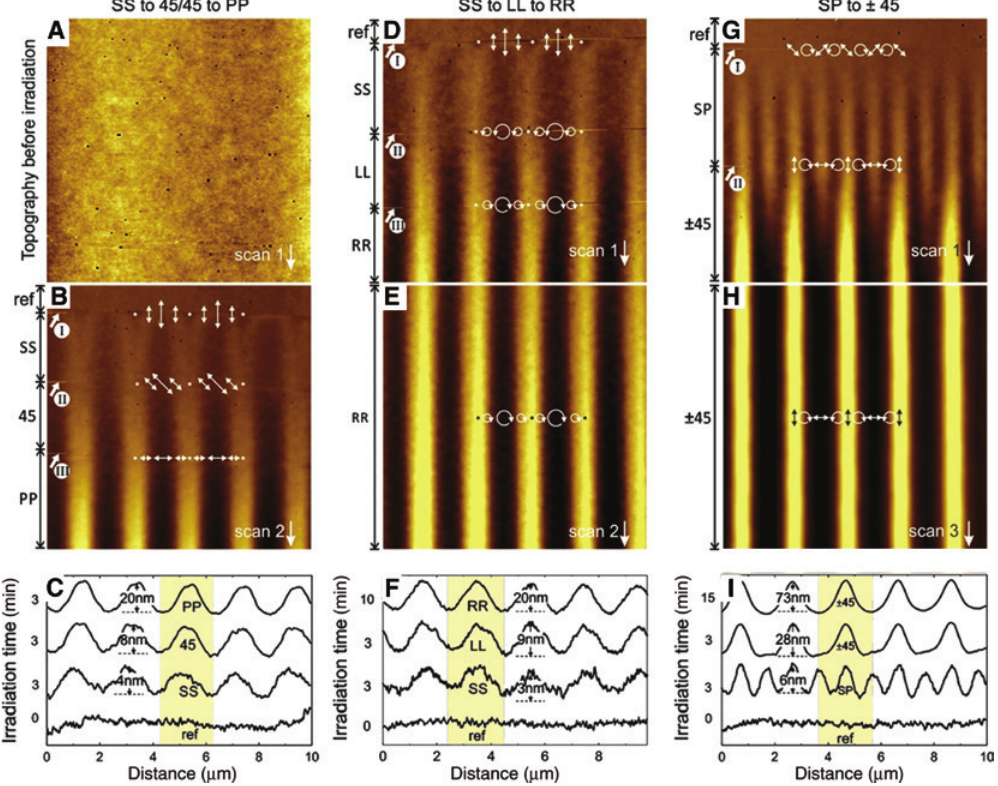
Figure 4: SRGs induced by different polarization combination and recorded by real-time in situ AFM. The vertical direction in the AFM images corresponds to a time axis. (A) Topography before the irradiation. (B) Time evolution of the film topography obtained by switching the polarization of the two interfering beams from S-S to 45 ° -45 ° to P-P at the positions indicated by the Roman numbers. (D–E) Same as before for polarization switches from S-S, to left circular (L-L) and to right-circular (R-R). (G–H) Same as before for the pure polarization interference patterns produced by S-P and + 45 ° / − 45 ° polarized beams. The topographic profiles relative to each polarization configuration are shown in panels (C, F, I). Reprinted from [121] with permission from Springer, copyright